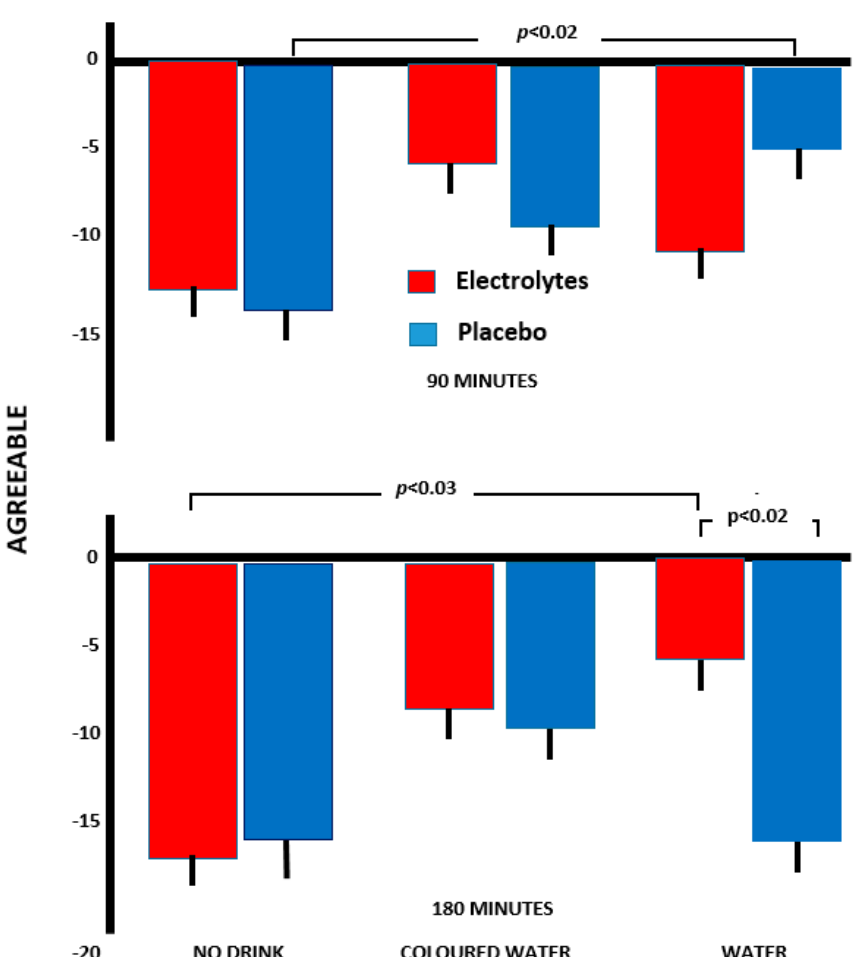
Figure 1. The influence of various drinks on changes over the morning in agreeableness. The data are means +/ − standard errors.